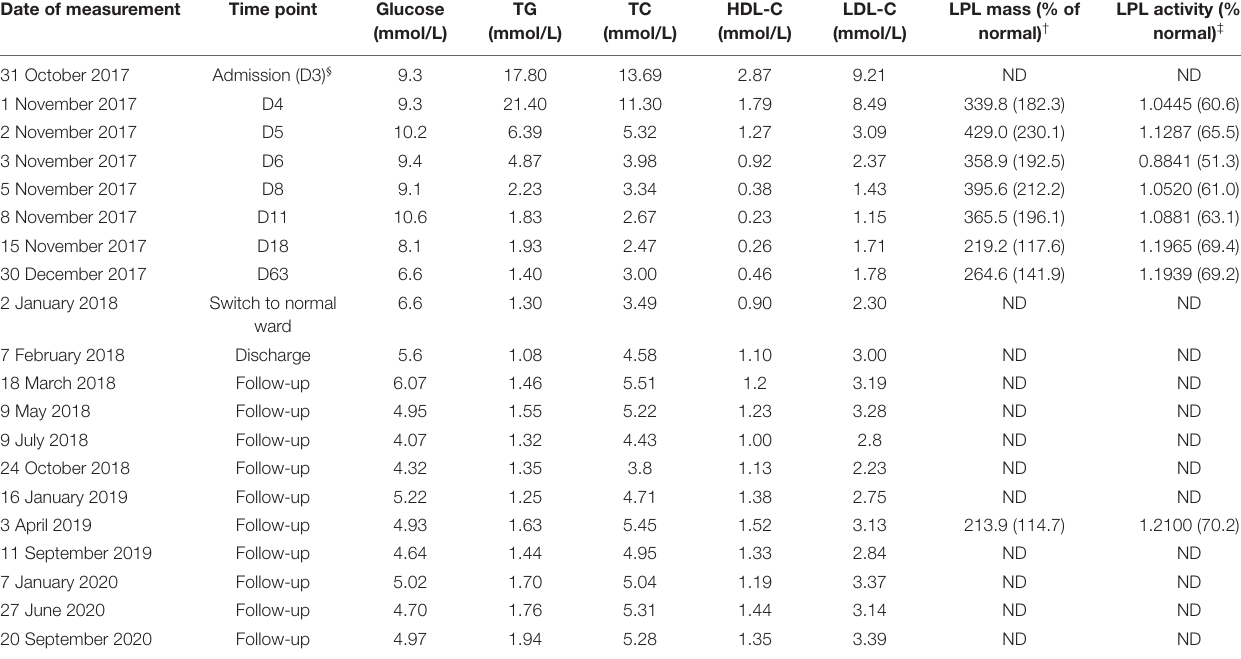
FIGURE 1 | Dynamic changes of the fasting plasma TG levels, post-heparin LPL mass and LPL activity during hospitalization and follow-up periods of the patient with alcohol-triggered HTG-AP. Day 3 (D3), numbered by reference to the time of disease onset, corresponds to the date when the patient was transferred to our service. See Table 1 for the precise values of the three parameters. HTG-AP, hypertriglyceridemia-induced acute pancreatitis; LPL, lipoprotein lipase; ICU, intensive care unit. TABLE 1 | Plasma lipid profiles and post-heparin LPL mass and activity in the patient. Date of